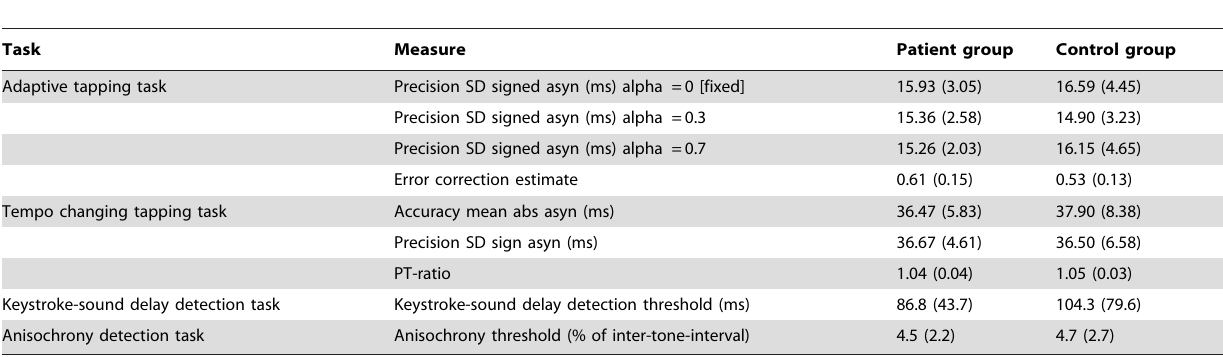
Table 2. Mean (SD) of the non-significant results for the different tasks and outcome measure separated per group and if applicable level of